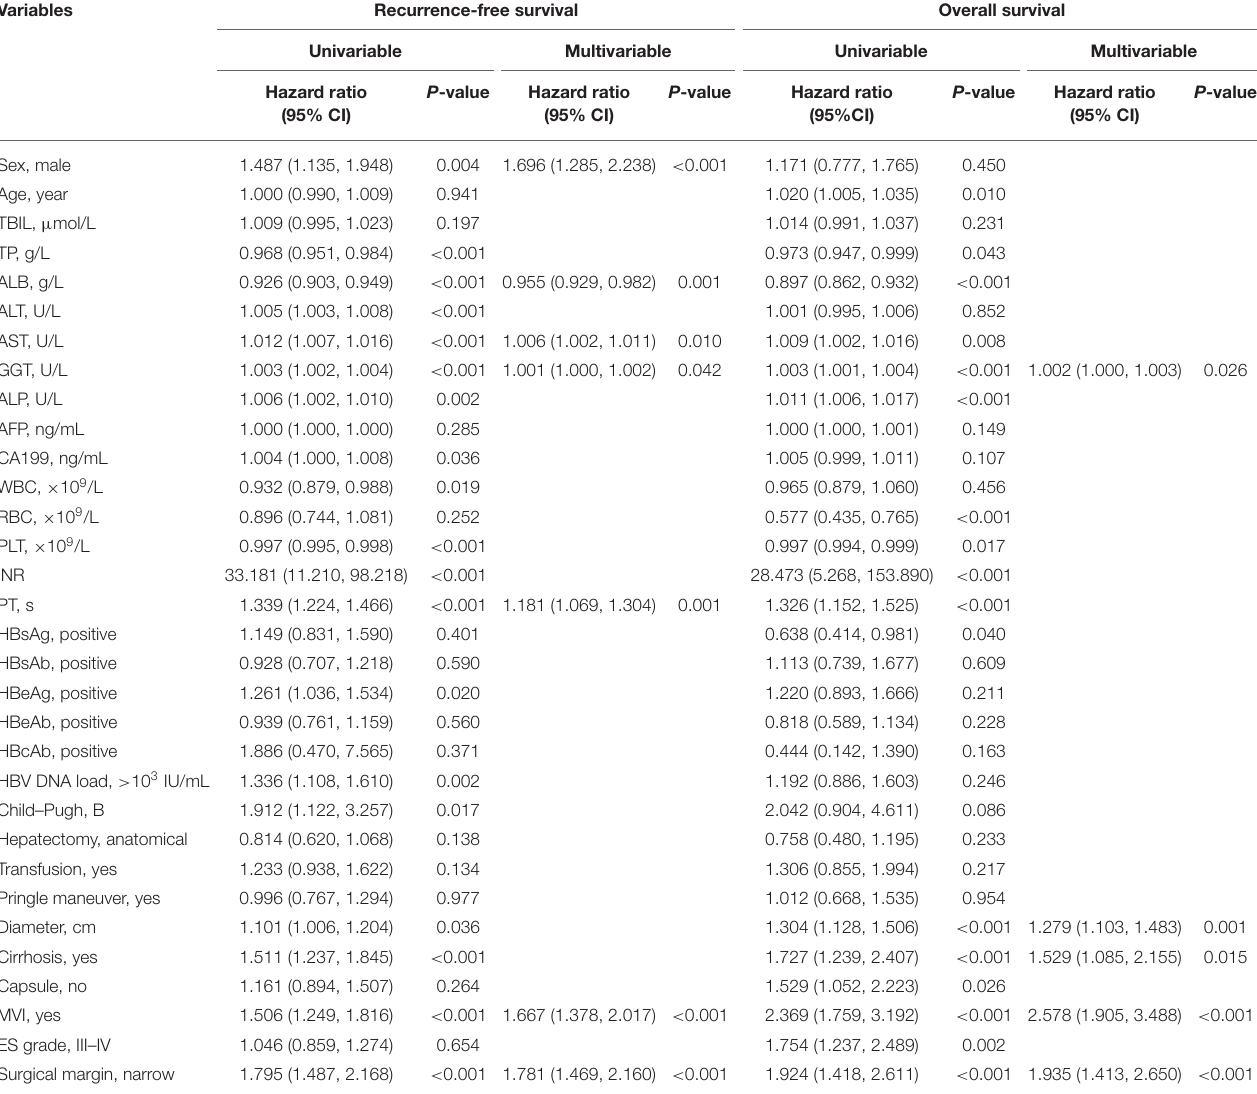
TABLE 2 | Prognosis factors of recurrence-free survival and overall survival in the whole patients. Variables Recurrence-free survival Overall survival Univariable Multivariable Univariable